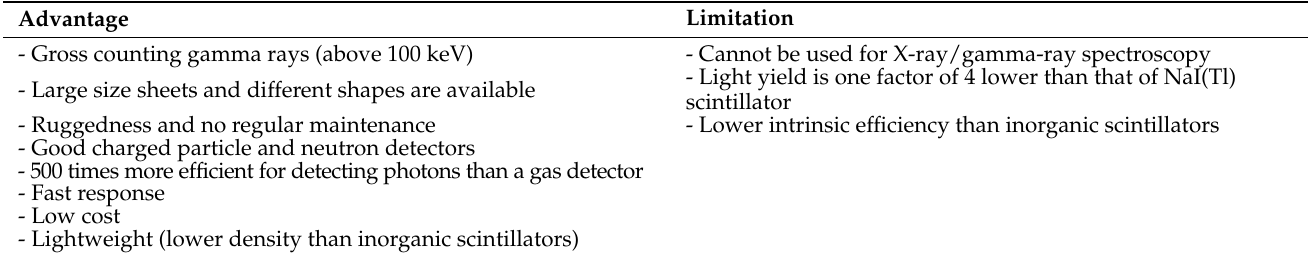
Table 3. Advantages and limitations of the use of plastic scintillators